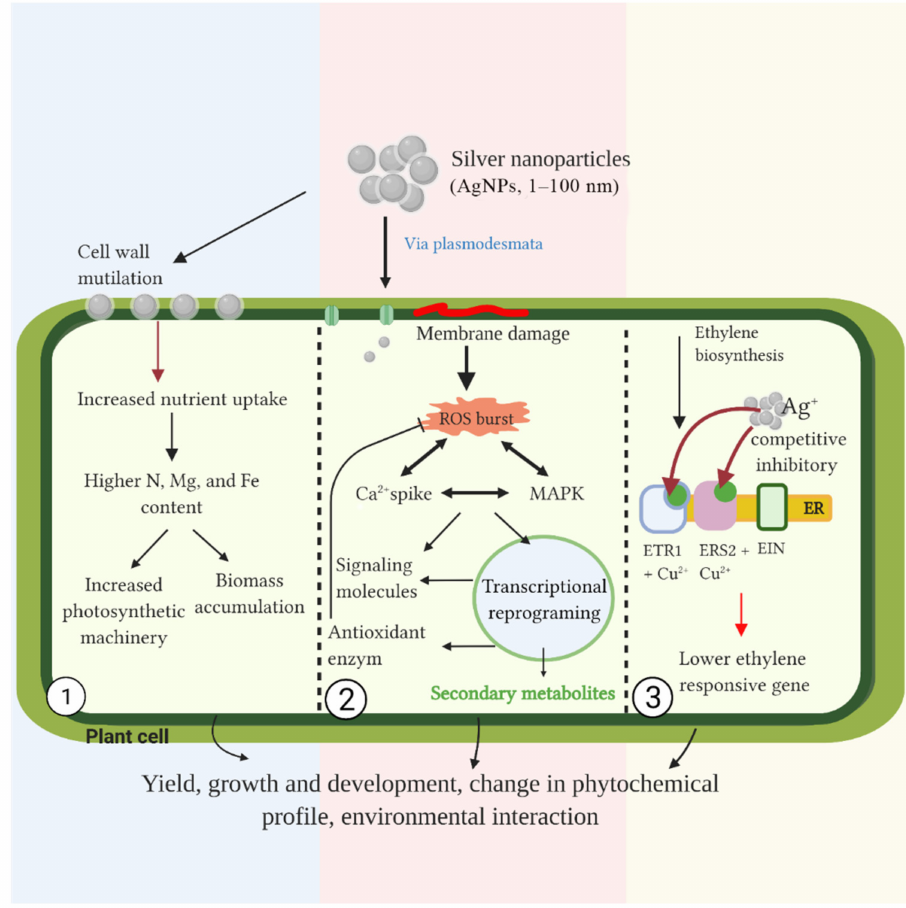
Figure 1. Possible mechanism of silver nanoparticles (AgNPs) effect on plant cell: (1) AgNPs enter plant cell by causing cell wall mutilation that improve nutrient uptake in a plant cell. This caused a higher accumulation of elemental nitrogen, magnesium, and iron, which had an impact on increas- ing photosynthetic machinery and biomass accumulation. (2) AgNPs entered via plasmodesmata and induced plant defensive mechanism which led to transcriptional reprogramming, resulting in improvement of secondary metabolism. (3) AgNPs in plant cells acted as competitive inhibitory for copper cofactor, resulting in low ethylene-responsive gene Adopted from